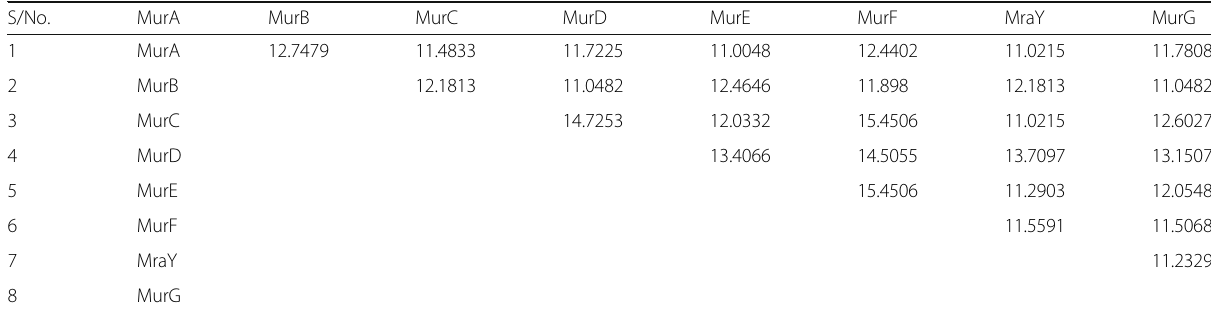
Table 6 Sequence identity statistics of eight Mur proteins from A . baumannii